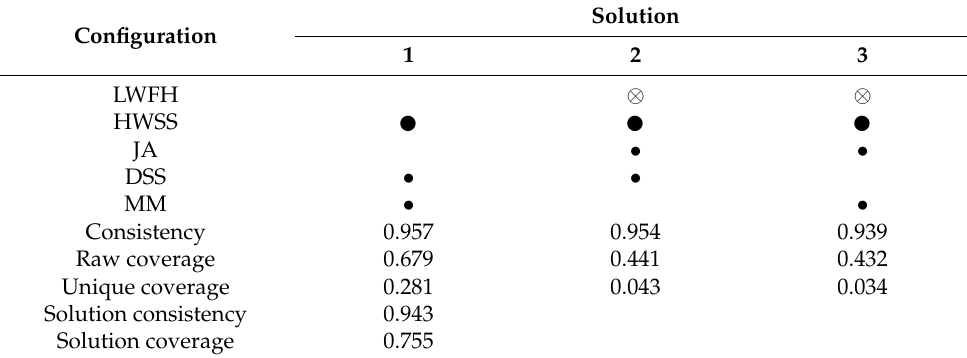
Table 4. Configurations for achieving high levels of EJS.